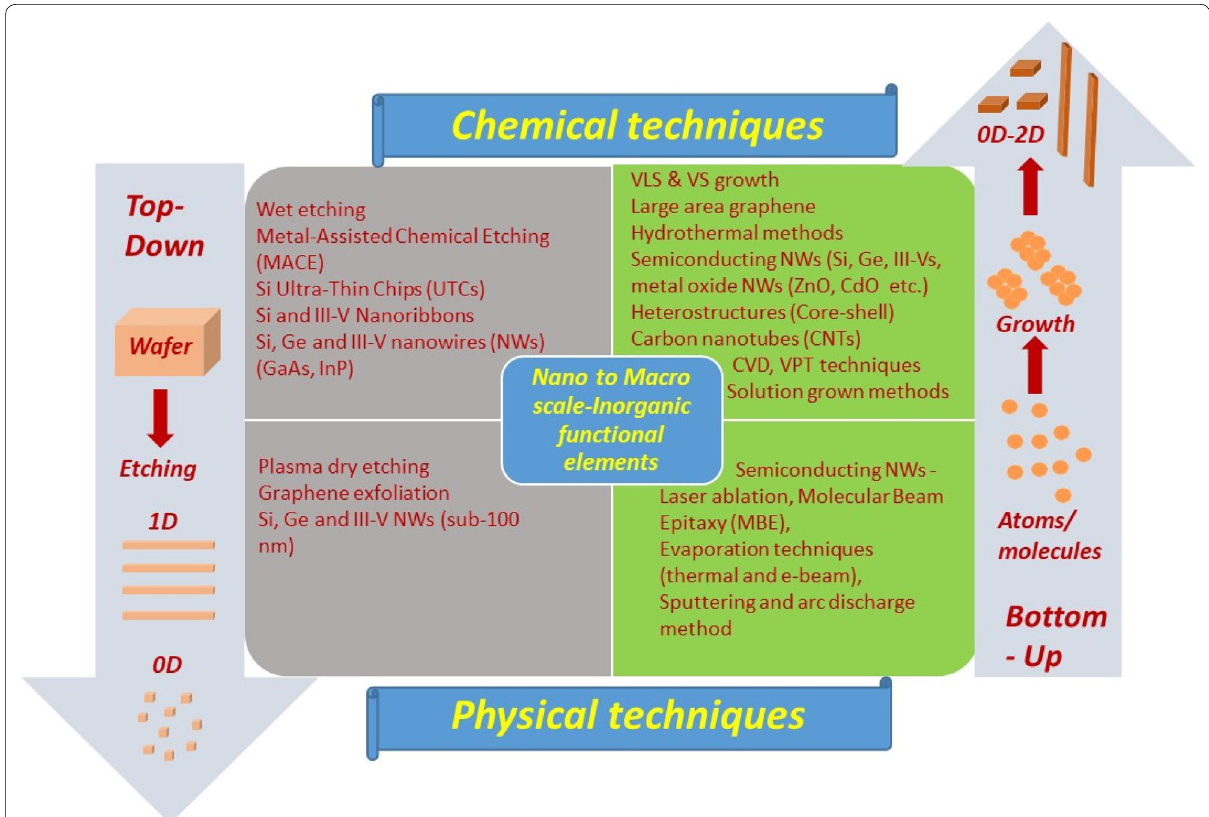
Fig. 3 Experimental domain for the fabrication of the various inorganic functional elements. Left column shows the chemical and physical techniques used for top-down approaches and right column represents bottom-up